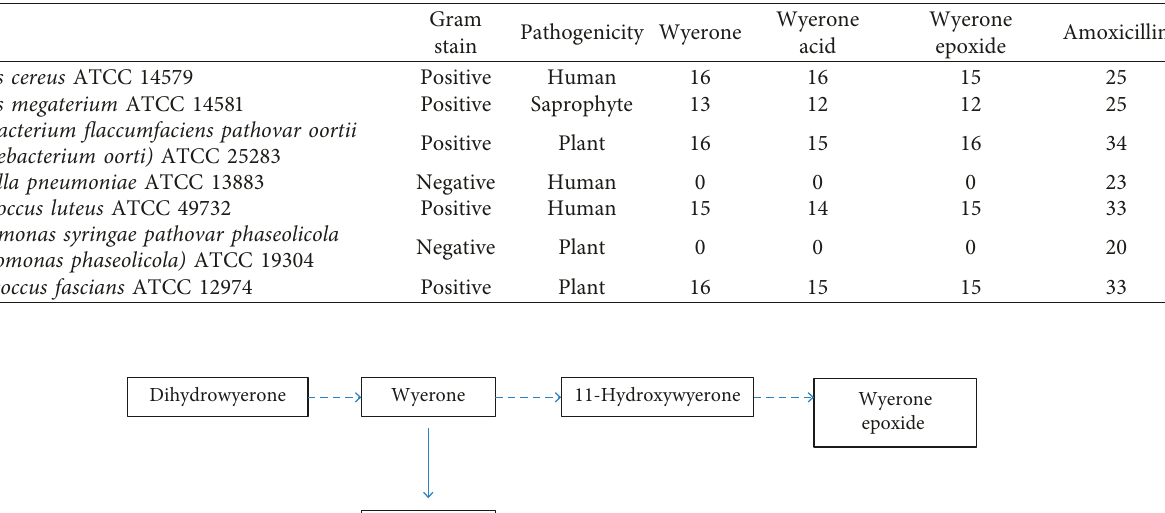
Table 4: Mean zones of inhibition in (mm), n � 2, for the three phytoalexins and amoxicillin (positive control) tested against different bacterial genera.